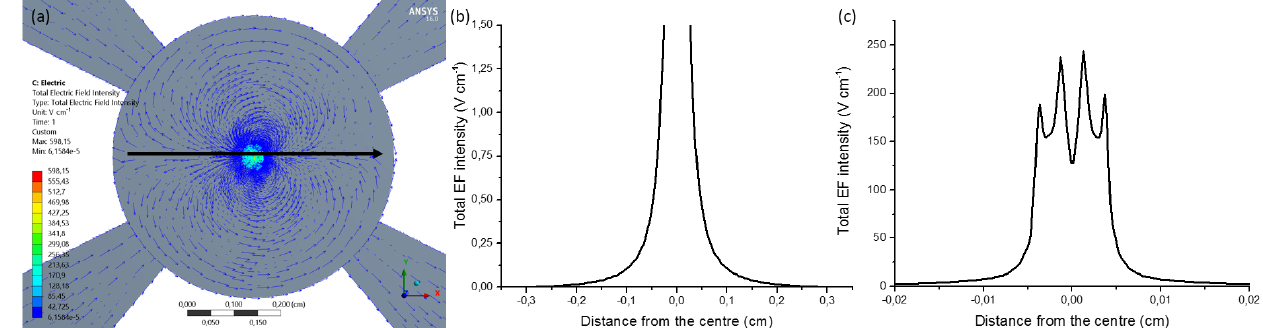
Figure 5. Simulation of the EF distribution using ANSYS 16.0. (a) EF distribution over the central cell well. Two anodes are placed at the end of the channels on the left-hand side, whilst two cathodes are at the ends of the right-hand side channels; EF profile at the region marked by the arrow over a (b) 3mm radius over the channel and (c) at a 200µm radius over the electrodes where the EF intensity is at its maximum. Green represents the maximum EF intensity felt at the cell chamber, whilst blue indicates low EF. Note that the two electrode openings are the areas with higher field intensity represented by the two peaks before and the two peaks after the central point 0.0. Scale bar